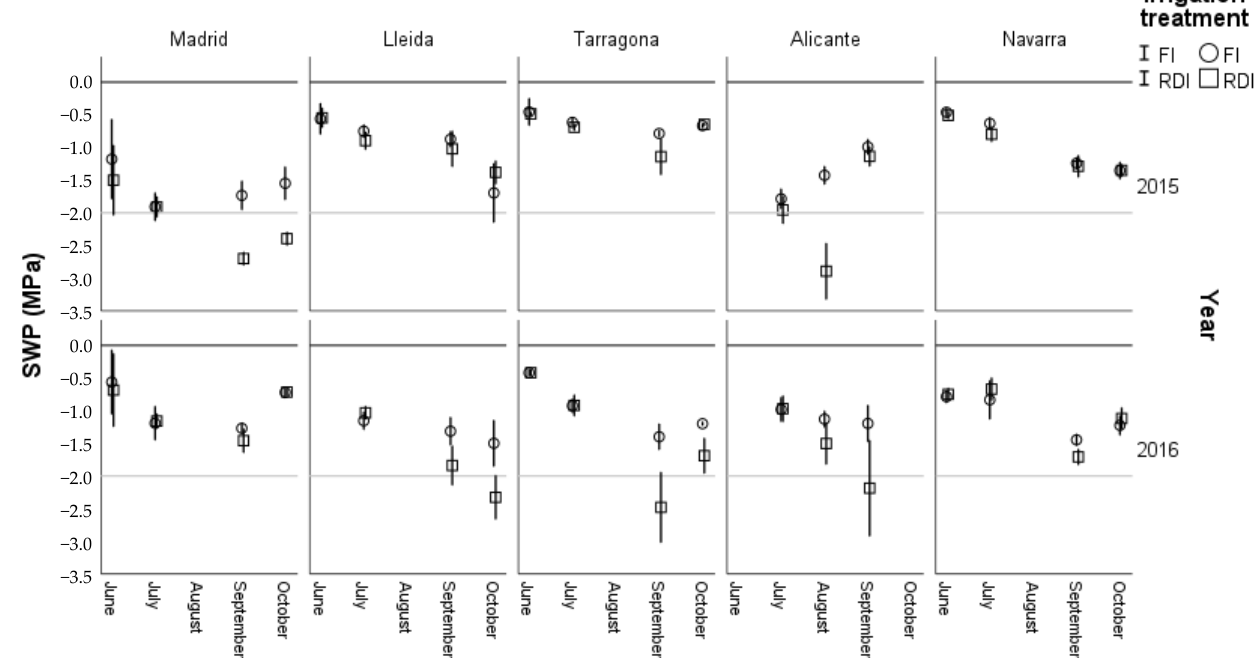
Figure 2. Midday stem water potential (SWP) of the irrigation treatments (FI: full irrigation; RDI: regulated deficit irrigation) at different times each year and plot location (n = 4). Vertical error bars represent the mean standard deviation. Grey horizontal line marks the threshold of moderate stress ( − 2 MPa).